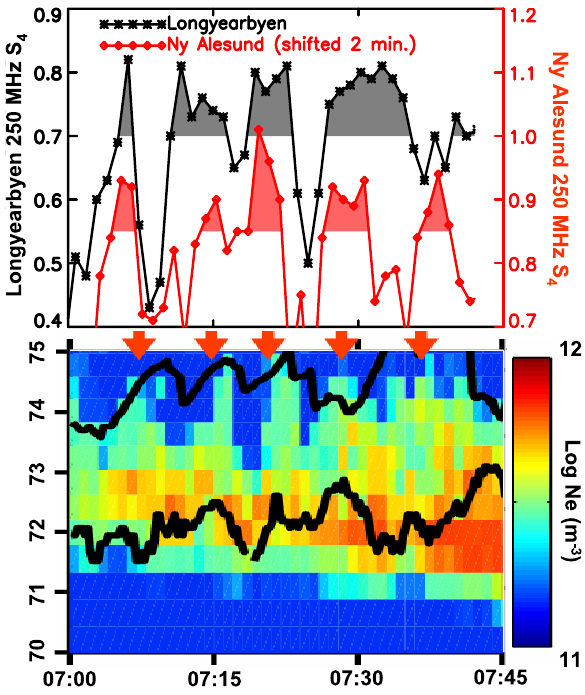
Fig. 3. The lower panel shows a sequence of five newly created patches entering the cusp, captured in polar flow from initially sub- auroral return flow. The red arrows show previously published pass- ing times over Longyearbyen of newly formed patches (Fig. 1m). The left axis is magnetic latitude, and the color scale shows the elec- tron density (Log Ne) along the line-of-sight of the EISCAT VHF radar. Due to Earth’s curvature, 71 ◦ /73 ◦ /75 ◦ magnetic latitude is at 300/450/620km altitude. The upper panel shows the passage of five strong scintillation events over Longyearbyen (dark grey) coincident with the entering patches (red arrows). The red areas show more severe scintillation when the same patches have moved ∼ 100km poleward to Ny- ˚Alesund. The time scale of the red curve is shifted ∼ 2min to account for the flow speed. The S4 scintillation index has grown from less than 0.8 over Longyearbyen to greater than 0.9 over Ny-